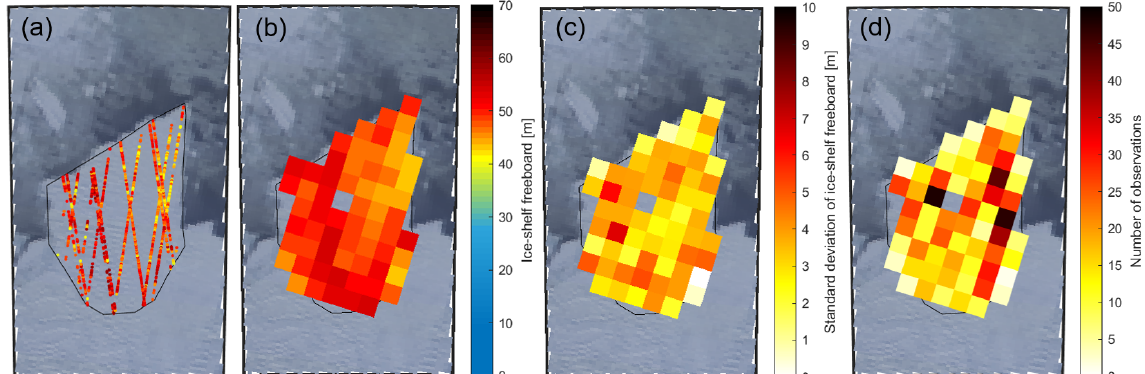
Figure 4. Initial freeboard heights of the B30 iceberg overlain on a MODIS image on 19 March 2012 (before calving). (a) Filtered CryoSat-2 measurements of 145d before calving, (b) gridded CryoSat-2 data, (c) standard deviation of the gridding, and (d) number of measurements per grid